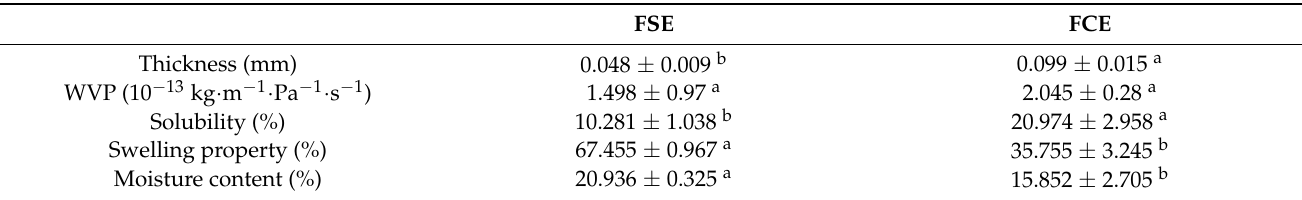
Moisture content (%) Values are presented as mean ± standard deviation. Different letters on the same line indicate significant differences ( p < 0.05). FSE: Film without extract; FCE: Film with